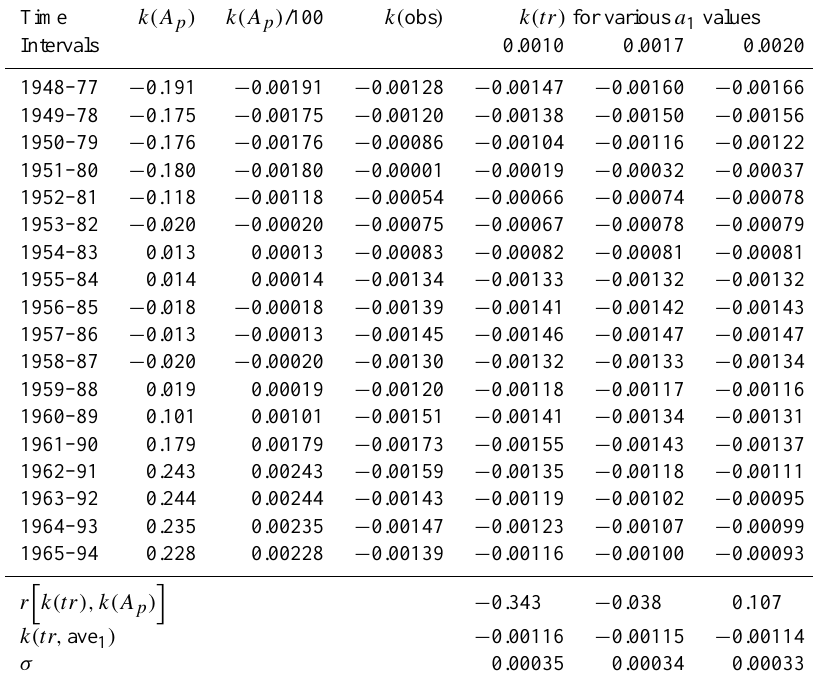
Time k(A p ) k(A p ) /100 k( obs ) k(tr) for various a 1 values Intervals 0.0010 0.0017